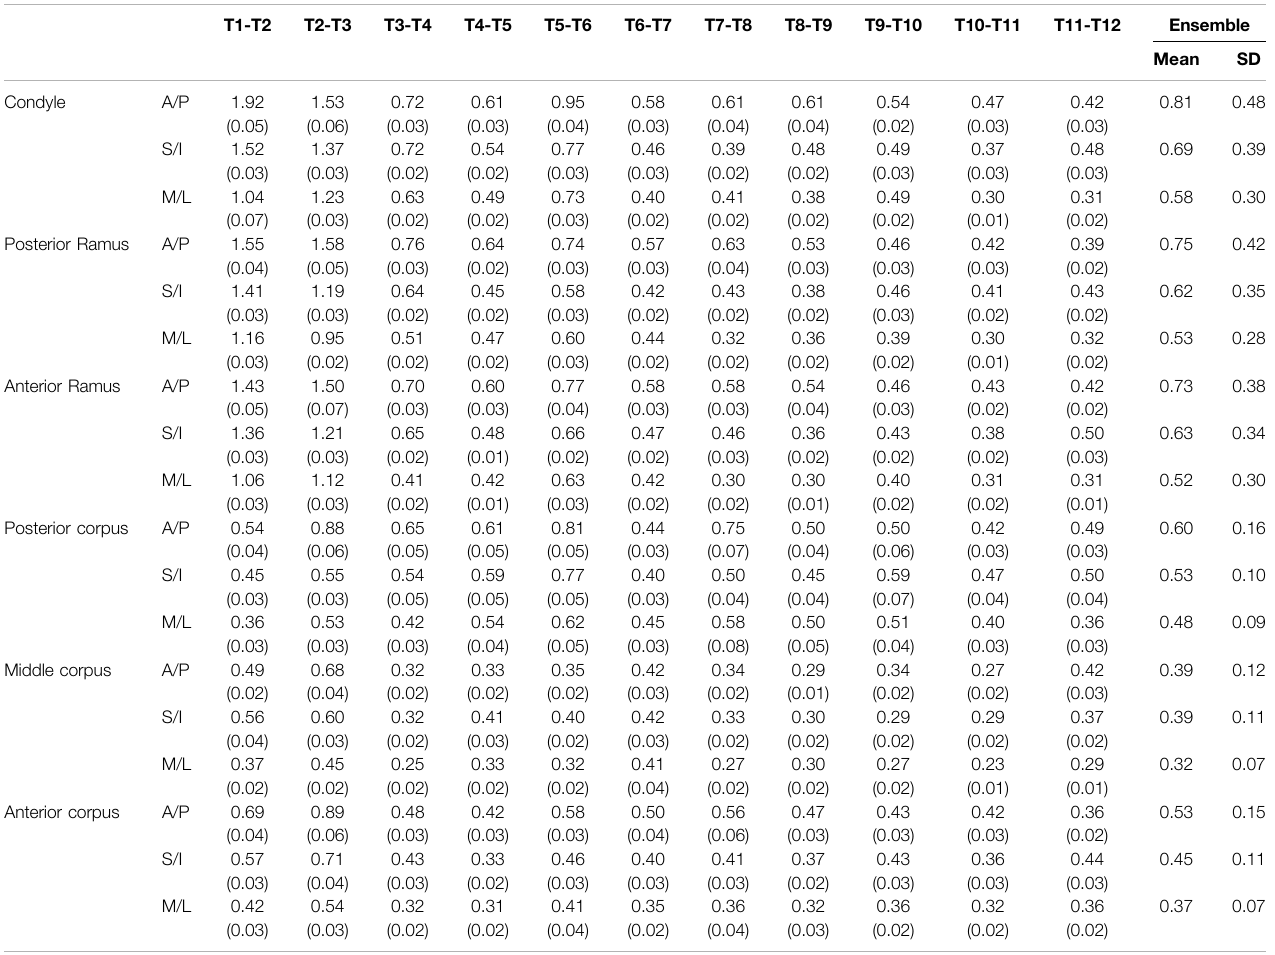
TABLE 4 | Means and standard deviations (SD) of the monthly averaged anterior/posterior (A/P), superior/inferior (S/I), medial/lateral (M/L), and total growth rates over each of the six regions of the mandible over the monitoring period of one year. ( n = 8; unit: